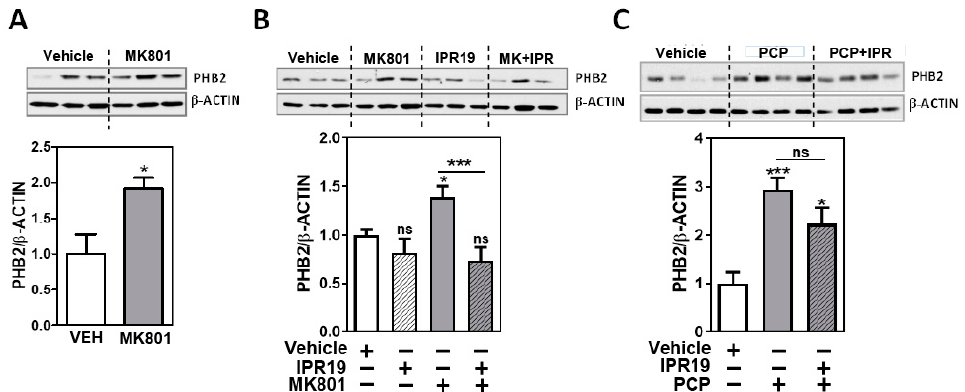
Figure 2. PHB2 protein levels were regulated by a POP inhibitor (IPR19) in the frontal cortex of mice acutely treated with MK801: Representative immunoblot images for PHB2 and β -actin in untreated and treated animals are shown. Each bar represents the mean and the standard error of the mean for each group for PHB2 normalized to β -actin. ( A , B ) PHB2 protein levels from the frontal cortex of 8-week-old C57Bl/6 J mice acutely treated (35 min) with vehicle (VEH) or the N-methyl-D-aspartate receptor antagonist MK801 (0.2 mg/kg), ( B ) and with the prolyl oligopeptidase inhibitor IPR19 (5 mg/kg), with and without MK801 ( B ) (n = 6, per group). ( C ) PHB2 protein levels from the frontal cortex of 8 to 10-week-old C57Bl/6 J mice subchronically treated (10 days) with vehicle (VEH; n = 5), phencyclidine (10 mg/kg PCP; n = 8), or PCP with IPR19 (n=8). In both experiments ( B , C ), the same IPR19 concentration and exposure times were used (5 mg/kg IPR19) ). Statistical analysis was performed using ANOVA followed by post hoc comparison between untreated condition and di ff erent treatments and the indicated comparison with MK801 or PCP group. (* p < 0.05, *** p < 0.001; ns, not signi fi cant).